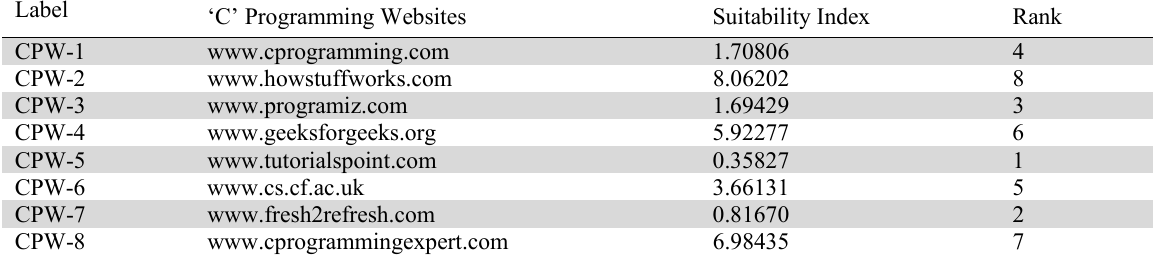
Rankings of E-learning websites obtained using WDBA